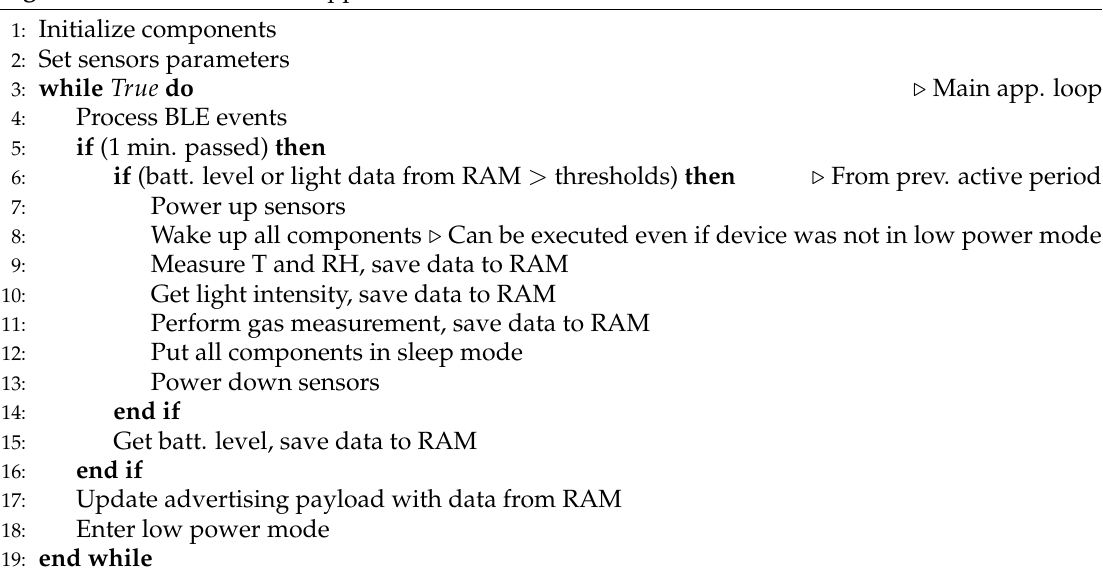
Algorithm 1 Wireless sensor application main